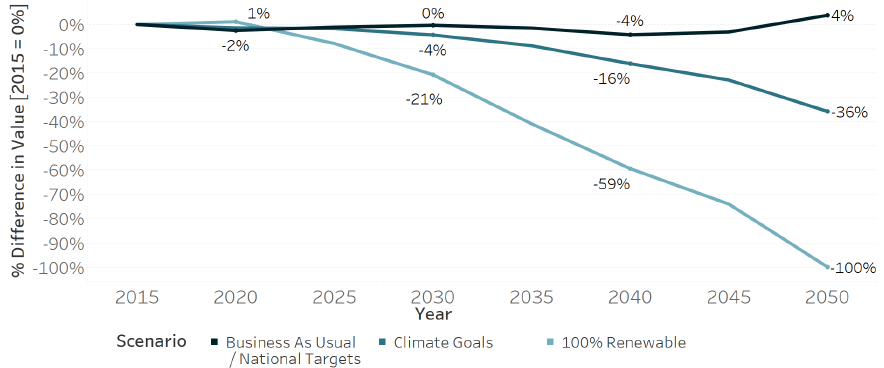
Figure 12. Annual CO 2 emissions per scenario (relative to